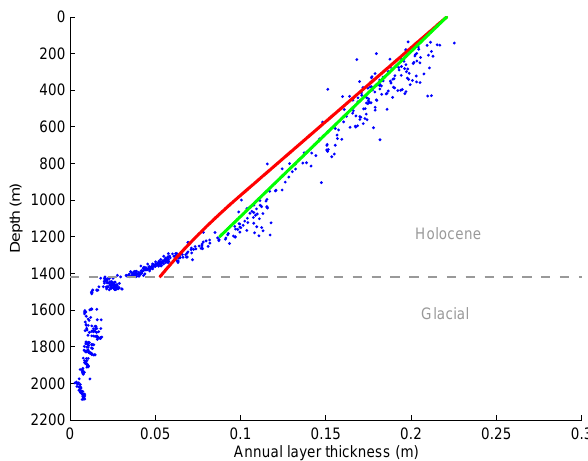
Fig. 5. Mean NEEM annual layer thicknesses between the match points presented in this work (blue dots) and predicted Holocene annual layer thicknesses calculated from a Dansgaard–Johnsen model with constant accumulation rate of 0.221myr − 1 and flow parameters determined from Monte Carlo analysis constrained by observed depth-age horizons back to 85kab2k (red line). The green line shows the predicted annual layer thicknesses from a D–J model with flow parameter values determined from Monte Carlo analysis constrained only by depth, age horizons younger than 7.9kab2k. The transition from the glacial to the Holocene (11.7kab2k) is marked with a horizontal grey line. High-frequency variability in the observed annual layer thicknesses caused by closely spaced match points in the top part of the core has been